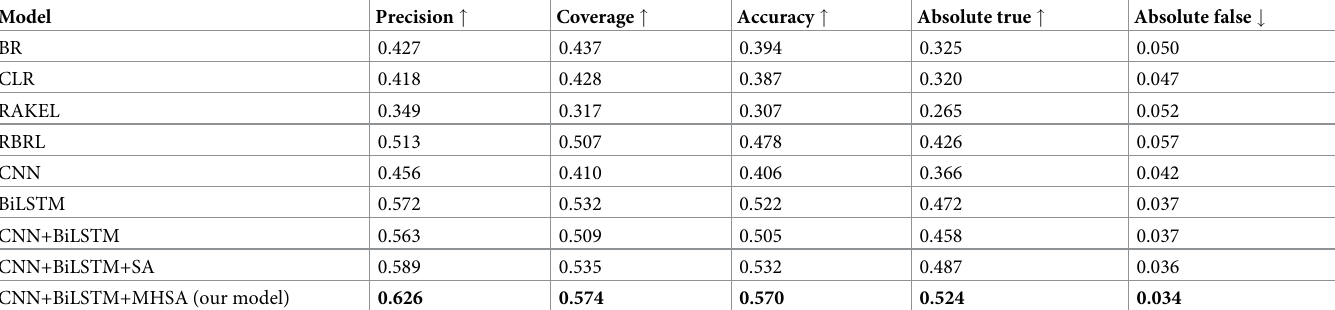
Table 2. The performance of multi-label therapeutic peptides prediction models on the test set. The highest value is highlighted in bold.